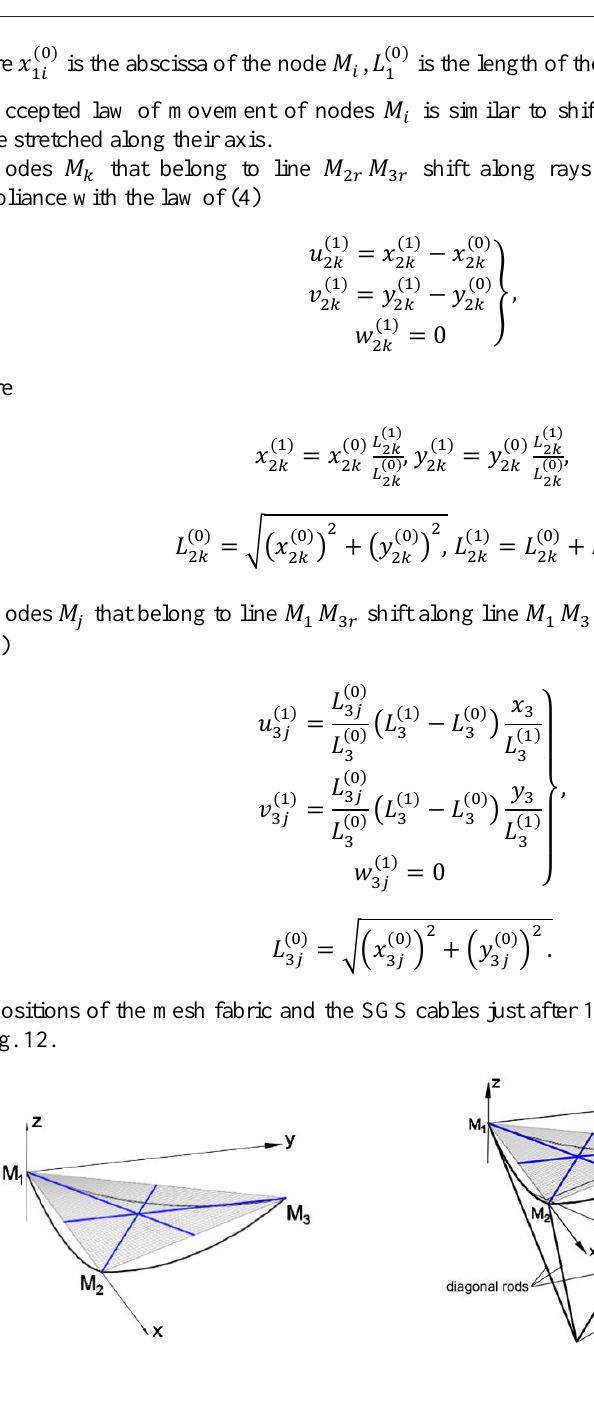
Fig. 12. Positions of the mesh fabric and the SGS cables just after 1 st step of